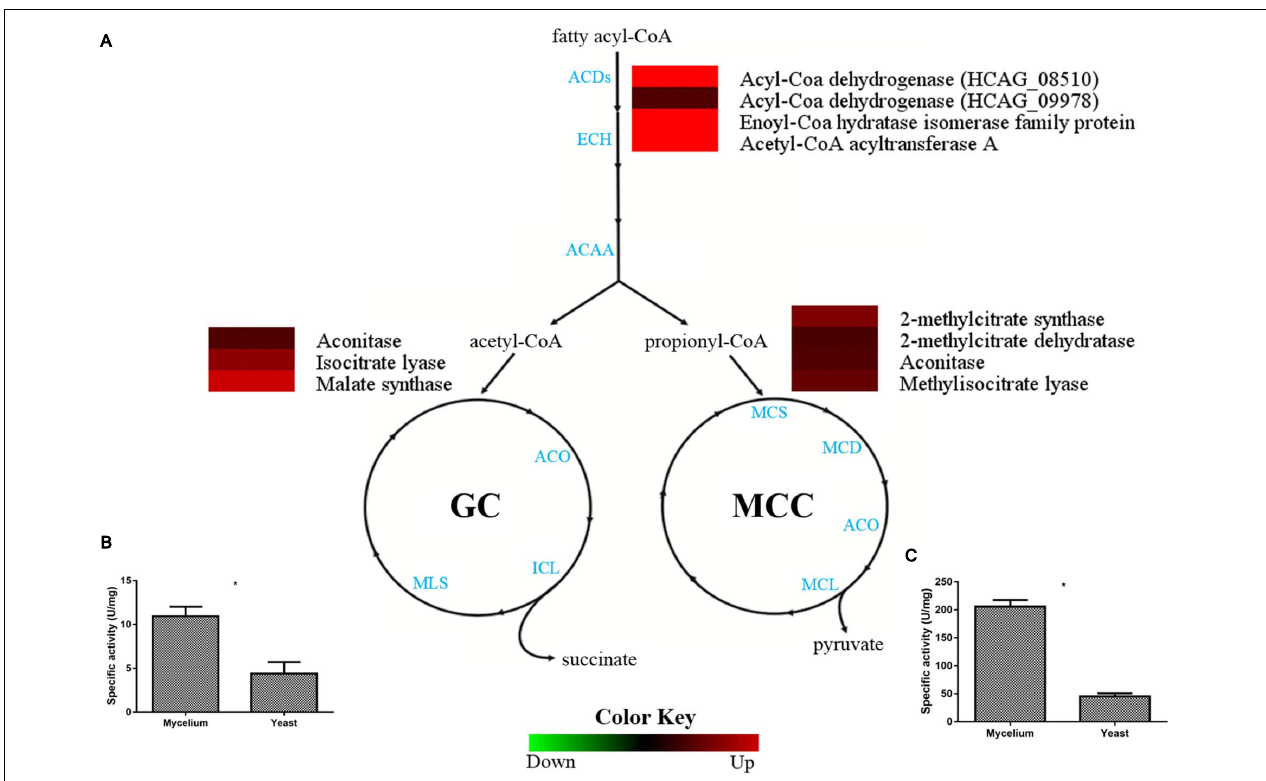
FIGURE 4 | Comparison of protein profiles related to beta-oxidation, methylcitrate, and glyoxylate cycles in H. capsulatum mycelium and yeast forms. Dataset comparisons were carried out as cited in the Figure 2 legend. (A) The diagram representing the metabolic pathways of beta-oxidation, methylcitrate, and glyoxylate cycles represents differentially abundant proteins in the mycelium and yeast phases. Changes in the abundance levels in the mycelium compared with the yeast are represented in the heat map. Experimental triplicate mean values are presented for the lowest (green) and the highest (red) abundance of H. capsulatum proteins in the mycelium form. Black indicates that no significant difference was observed. ACDs, Acyl-Coa dehydrogenases; ECH, enoyl-Coa hydratase; ACAA, Acetyl-CoA acyltransferase; ACO, aconitase; ICL, isocitrate lyase; MLS, malate synthase; MCS, 2-methylcitrate synthase; MCD, 2-methylcitrate dehydratase; MCL, methylisocitrate lyase; (B) Isocitrate lyase (ICL) activity was determined by measuring glyoxylate formation as its phenylhydrazone derivative under the two conditions. The specific activity of ICL was determined as the amount of enzyme required to form 1 µ mol of glyoxylate-phenylhydrazone per minute, per mg of total protein, and represented as U · mg-1. Errors bars represent standard deviation from three biological replicates. * p < 0.05. (C) Methylcitrate synthase measurement was determined in H. capsulatum yeast and mycelial phase cells, upon growth in Hams F12 media for 72 h (36 ◦ C) and 96 ◦ h (25 ◦ C), respectively. Activity was determined by nitrothiophenolate (2-mercapto-5-nitrobenzoate dianion) formation during the 5,5’-Dithiobis (2-nitrobenzoic acid) (DTNB) reaction with Coenzyme A, released during the condensation of oxaloacetate with